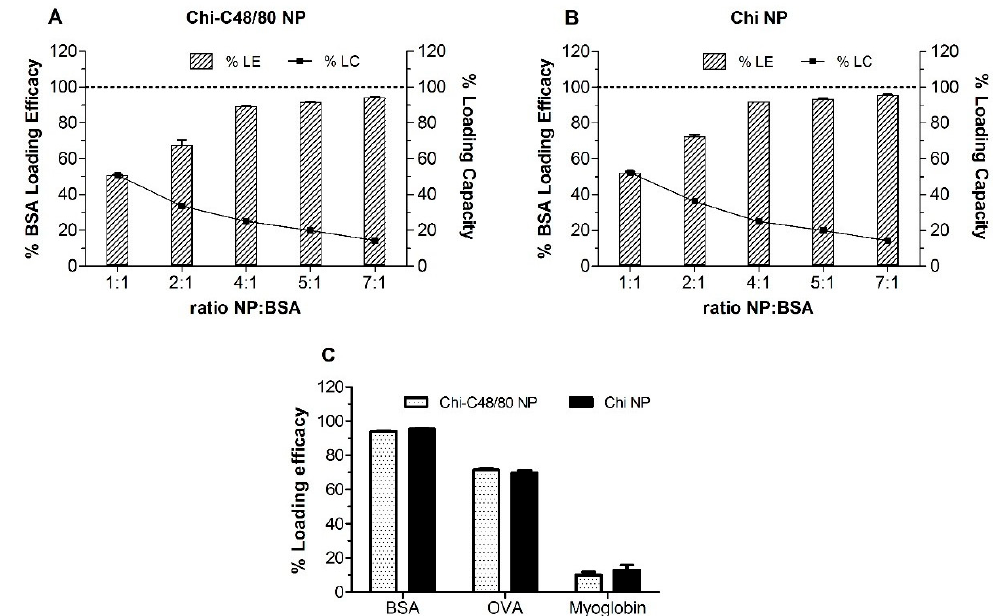
Figure 6. Loading of model antigens. Effect of NP/protein ratio on the protein adsorption to ( A ) Chi-C48/80 NPs and ( B ) Chi NPs. ( C ) Loading efficacy for bovine serum albumin (BSA), ovalbumin (OVA) and myoglobin at the NP/protein ratio of 7:1. Nanoparticles were incubated with different proteins for 60 min in acetate buffer, pH = 5.7 at RT. Loading efficacy (% LE) and loading capacity (% LC) were determined after quantification of unbound protein in the supernatant using the Bicinchoninic acid (BCA) assay. Bars represent mean ± SD, n = 3.